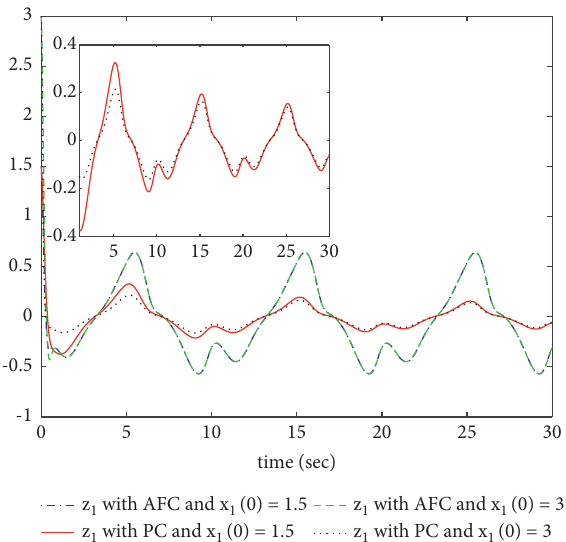
Figure 2: The comparison of tracking errors between PC and AFC with y